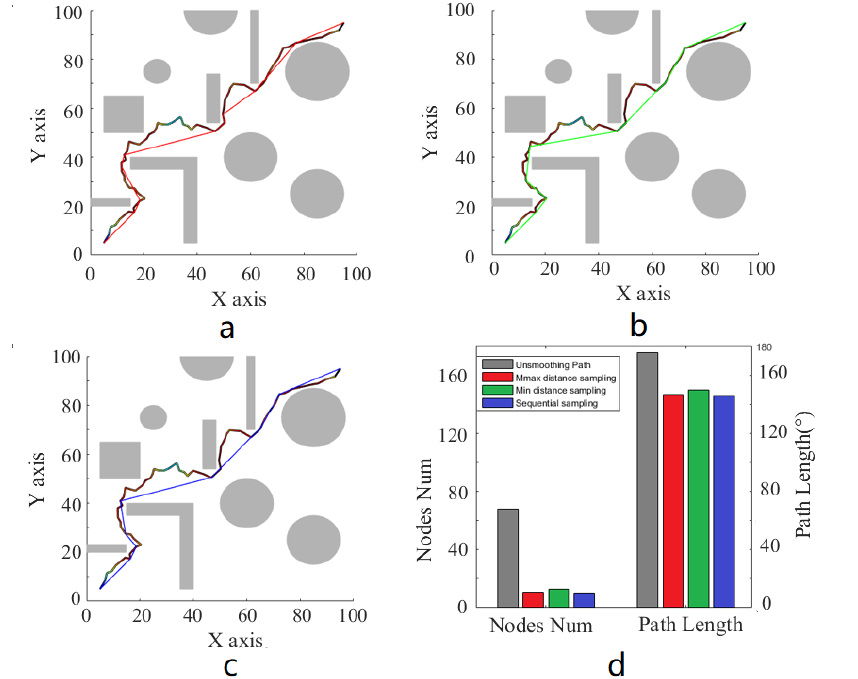
Figure 19. Smoothing results of different sampling methods. (( a ) maximum distance sampling, ( b ) minimum distance sampling, and ( c ) sequential sampling, and ( d ) the number of nodes and path length changes after